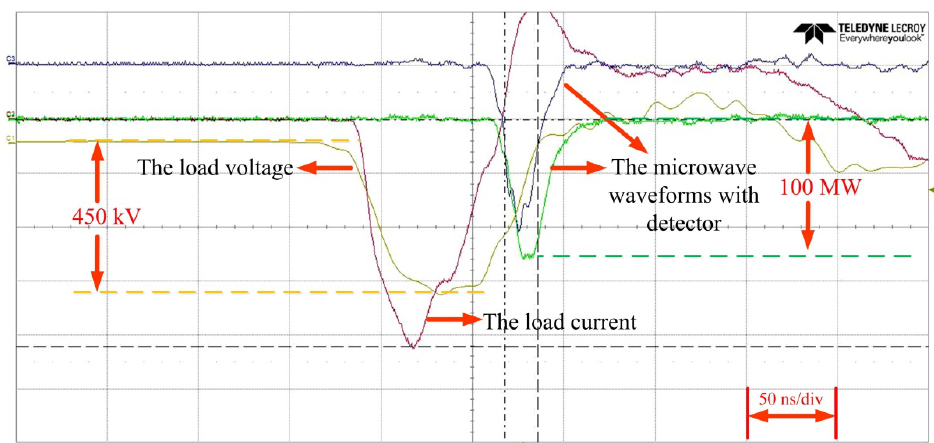
Figure 17. The typical waveforms on the transit time oscillator (TTO).